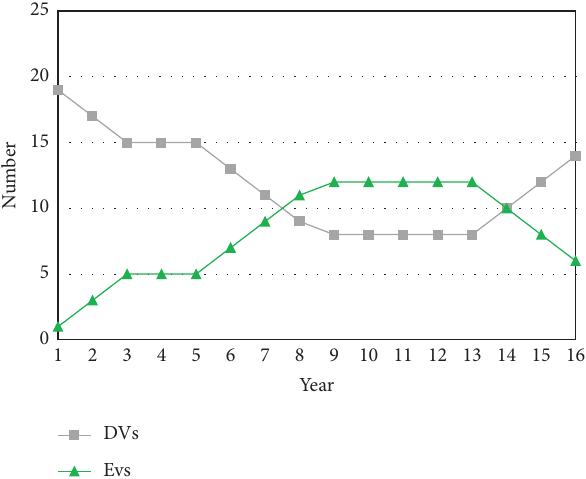
Figure 2: Number of vehicles used during the planning period.